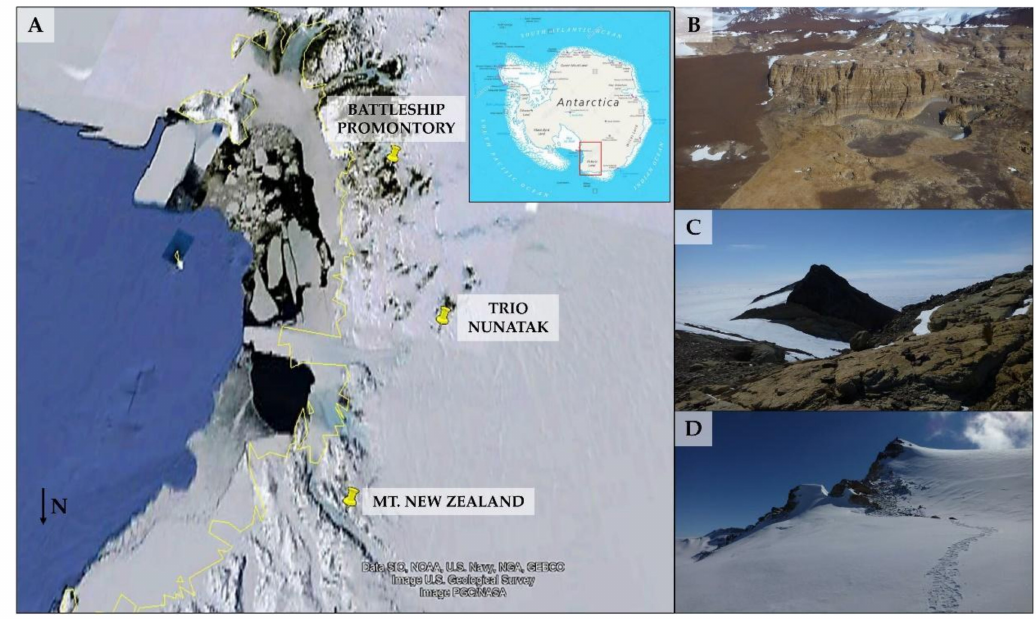
Figure 1. ( A ) Map of Antarctica—the Victoria Land (red square) is zoomed to show the sampling areas. The satellite photo was provided by Google Maps (2019 Google, TerraMetrics, Data SIO, NOAA, U.S.A. Navy, NGA, GEBCO). ( B ) Battleship Promontory; ( C ) Trio Nunatak; ( D ) Mt New